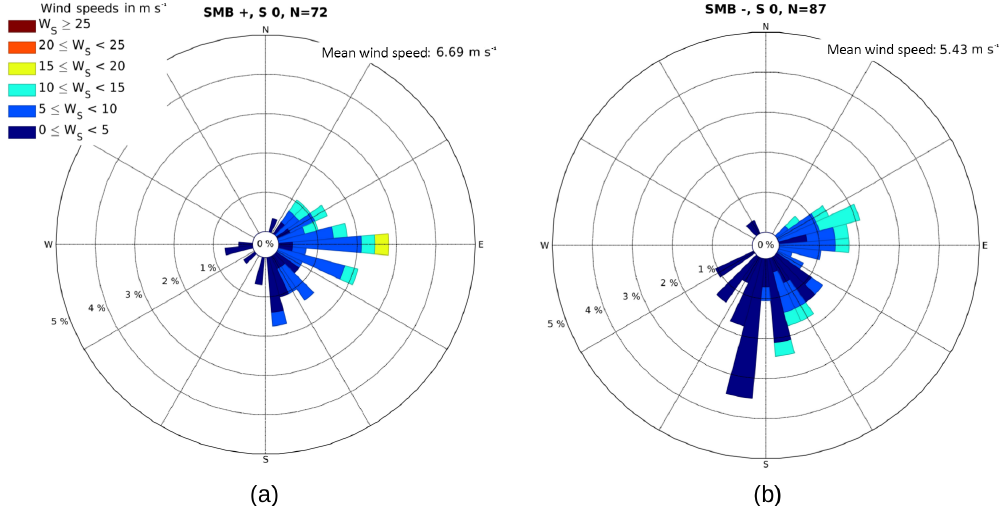
Figure 7. Wind speed and direction for the two events resulting in wind-induced accumulation (a) and ablation (b) without snowfall. N denotes the total number of events during our observation period.